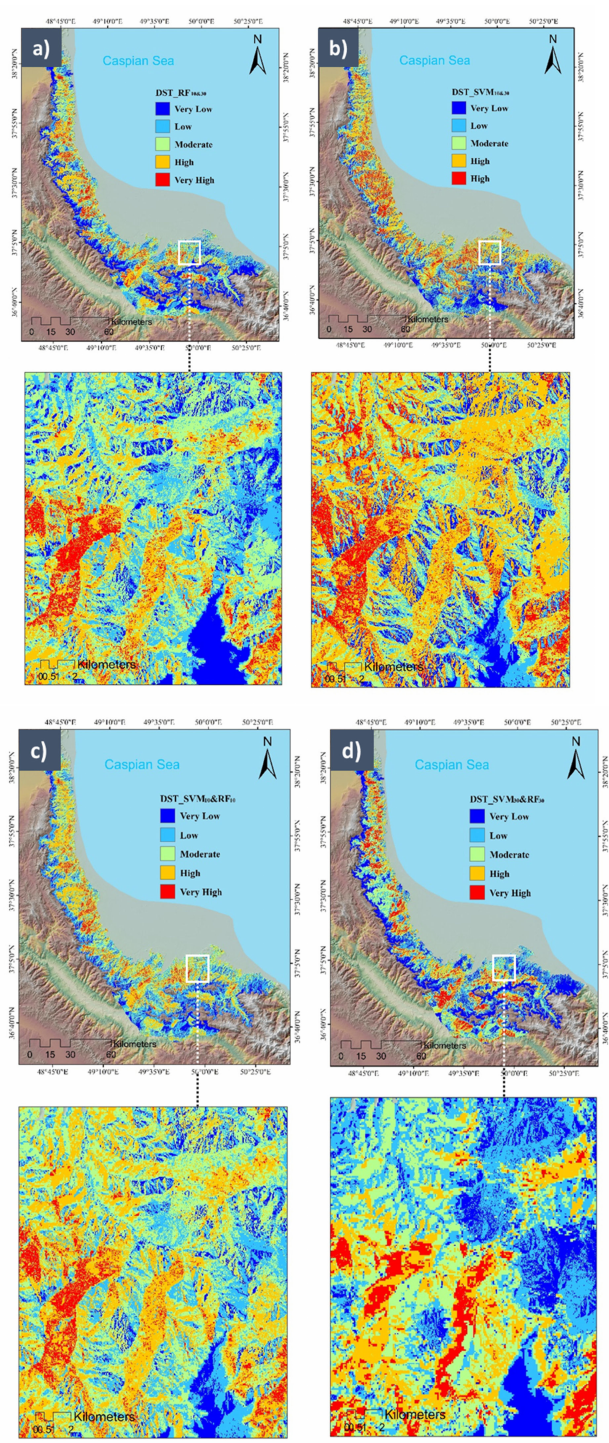
Figure 11. The resulting wildfire susceptibility prediction (WSP) maps from the DST technique by integrating ( a ) RF 10 & 30 , ( b ) SVM 10 & 30 , ( c ) SVM 10 & RF 10 , ( d ) SVM 30 & RF 30